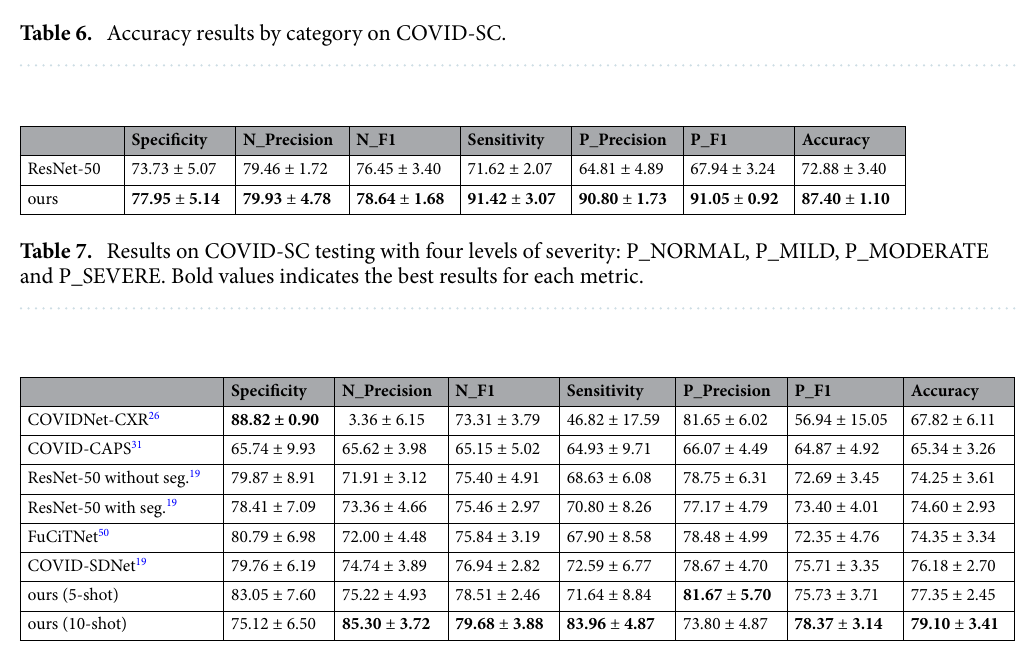
Table 8. Results on COVIDGR-1.0 testing with four levels of severity: P_NORMAL, P_MILD, P_ MODERATE and P_SEVERE. Bold values indicates the best results for each